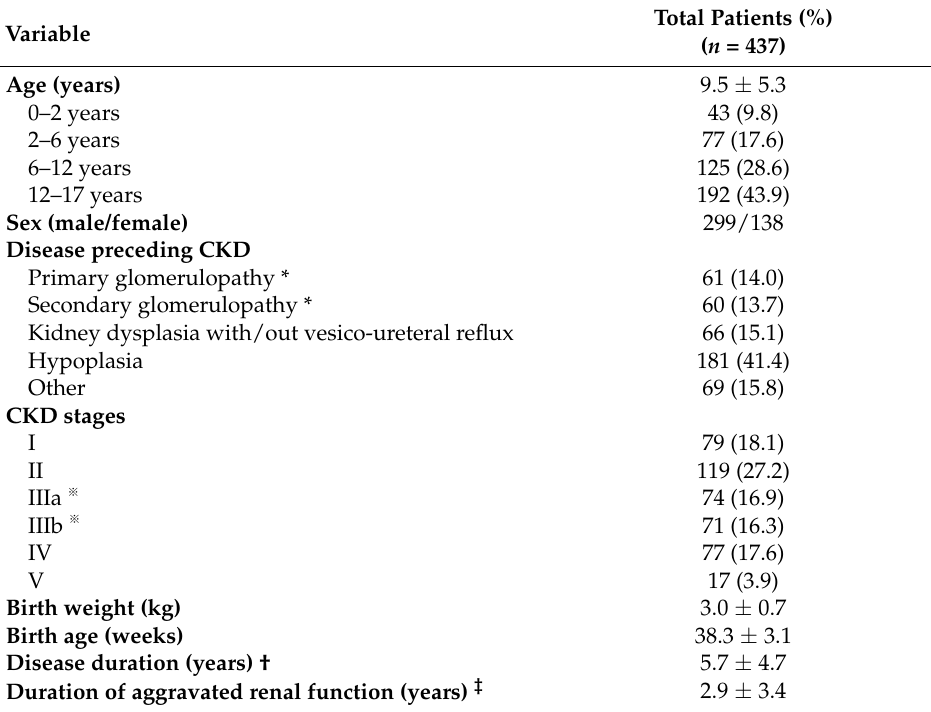
Table 1. Baseline demographics of the chronic kidney disease (CKD) patient cohort.